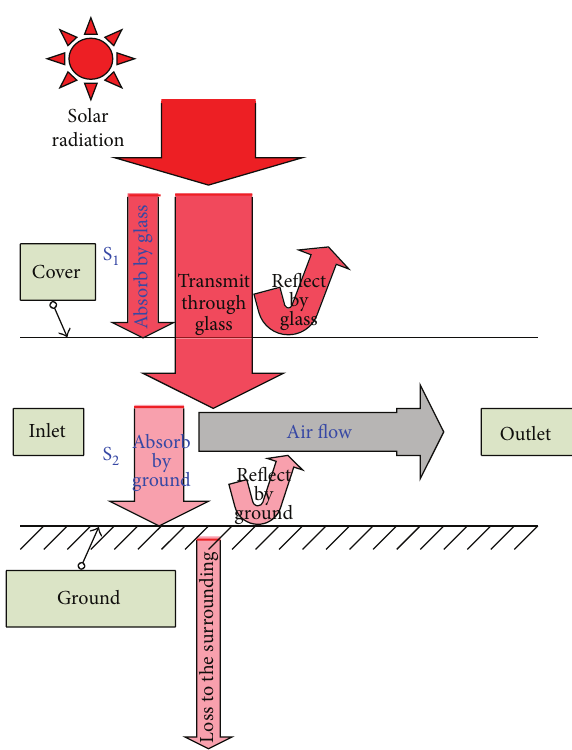
Figure 2: Thermal balance in the solar collector.